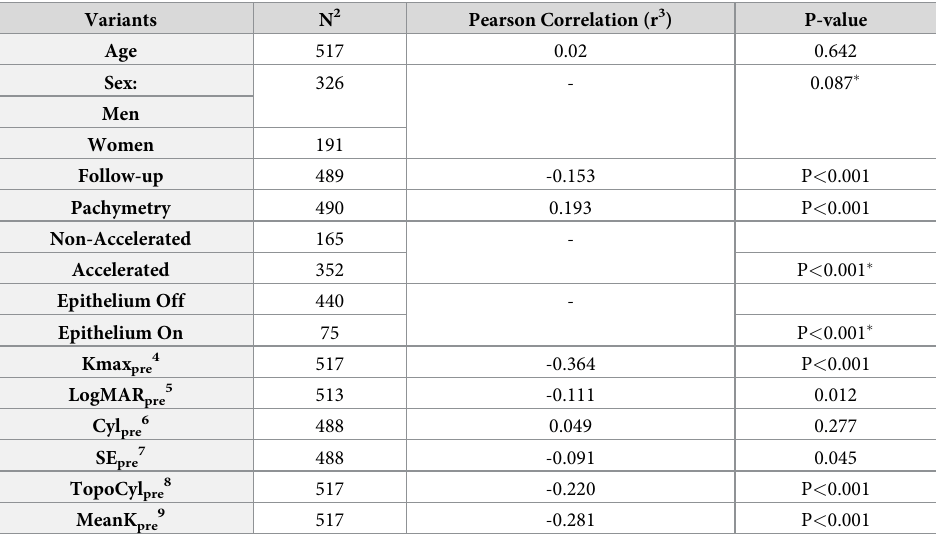
Table 3. Univariate analysis of variables affecting Delta Kmax. Variants N 2 Pearson Correlation (r 3 ) P-value